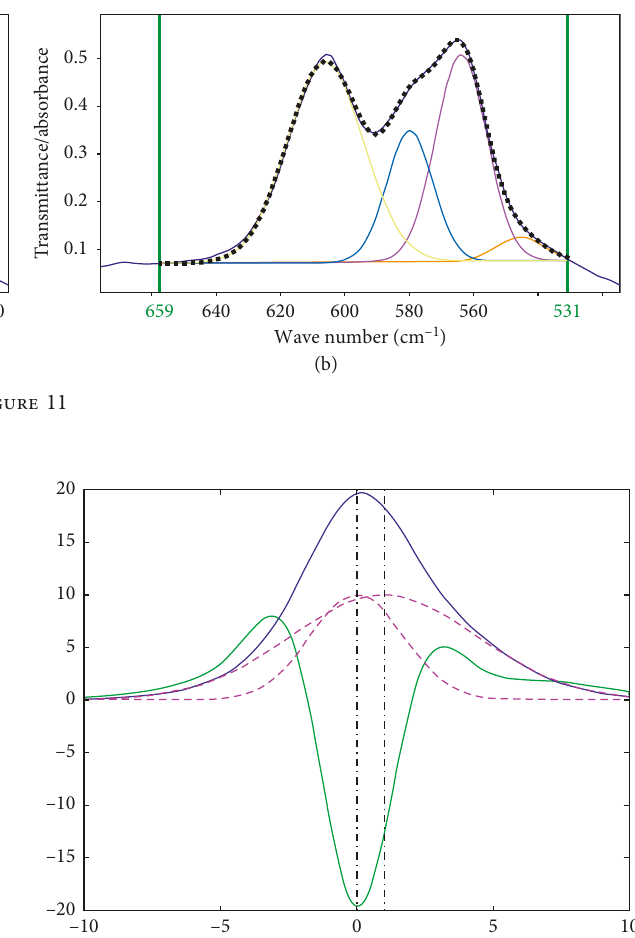
Figure 12: Gaussian with FWHM � 1 (blue) and its second de- rivative (green).